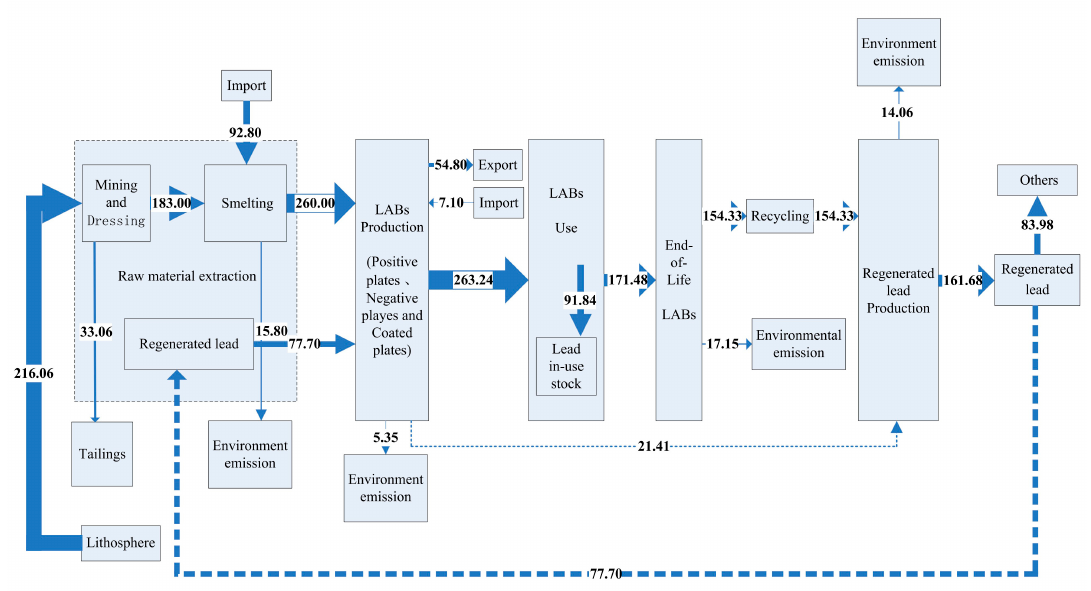
Figure 5. Lead flow of LABs in China in 2014 ( × 10 4 t) (note: solid lines represent input and output flows; dotted lines represent circular flows).